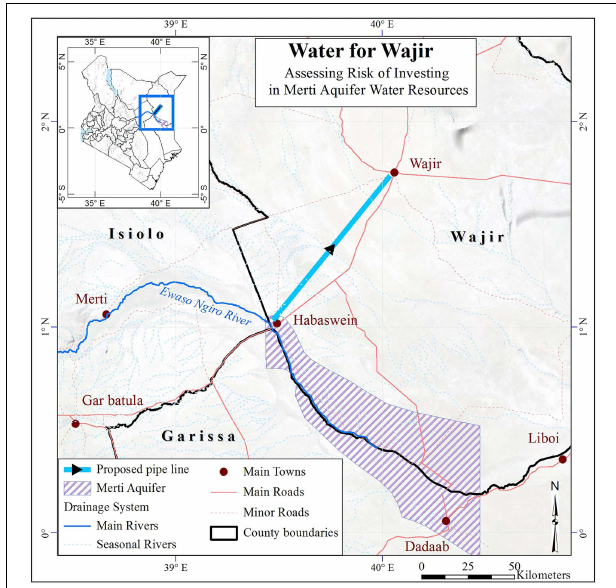
FIGURE 2 | Geographic context of the proposed Habaswein-Wajir Water Supply